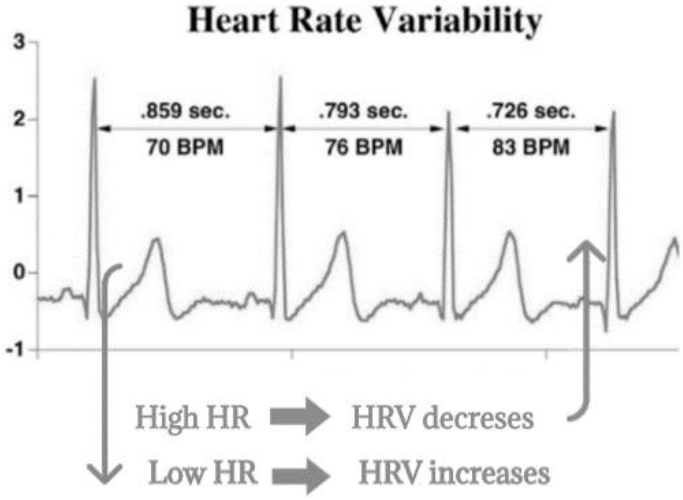
Figure 1. Heart rate variability interpretation. Abbreviations: BPM, Beats per Minute; HR, Heart Rate; HRV, Heart Rate Variability.